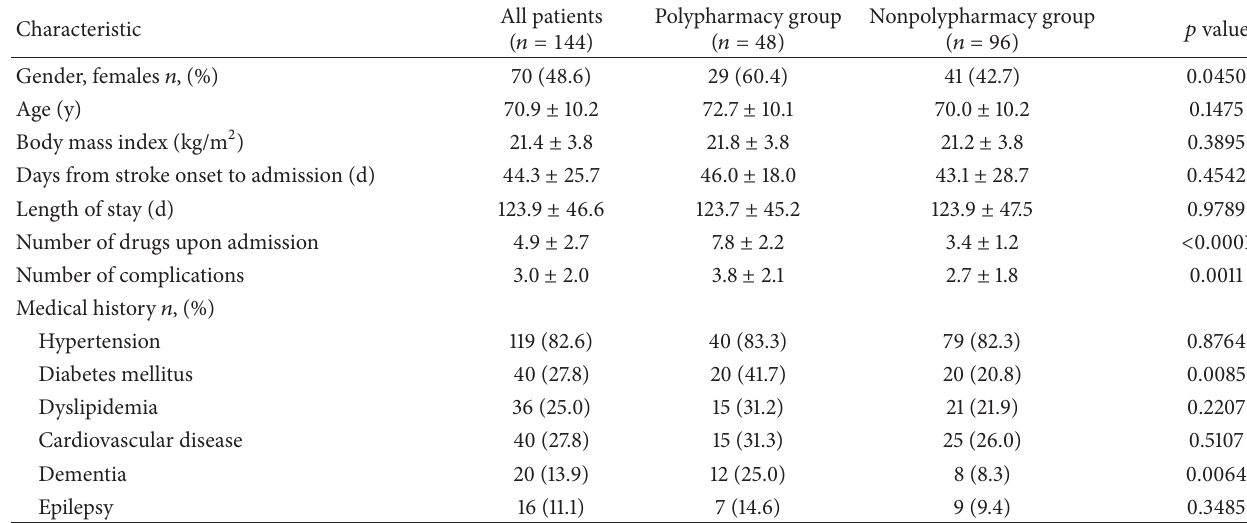
Table 1: Comparison of patient background characteristic data.